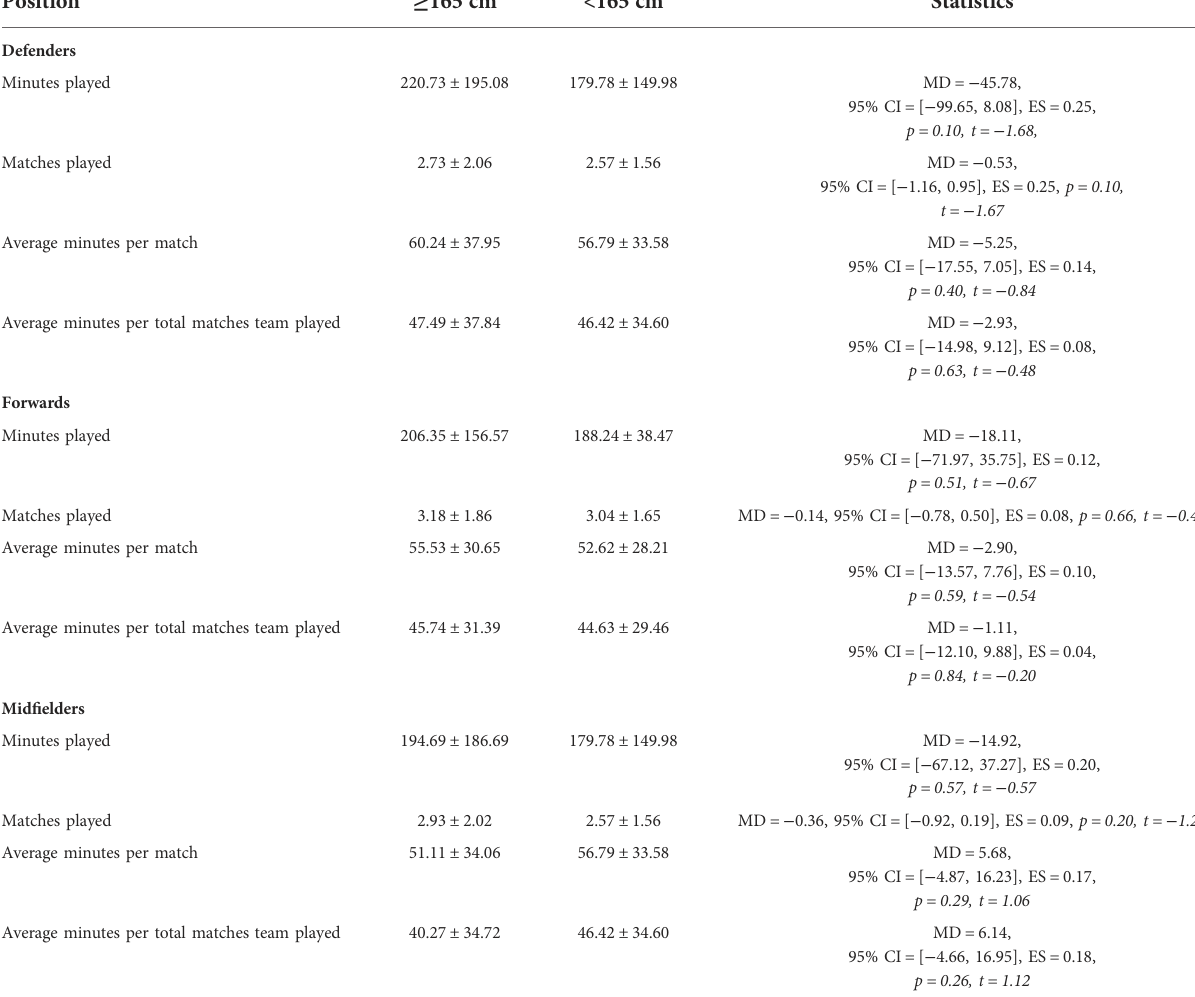
TABLE 2 Playing time for defenders, forwards, and mid fi elders ≥ 165 cm and <165